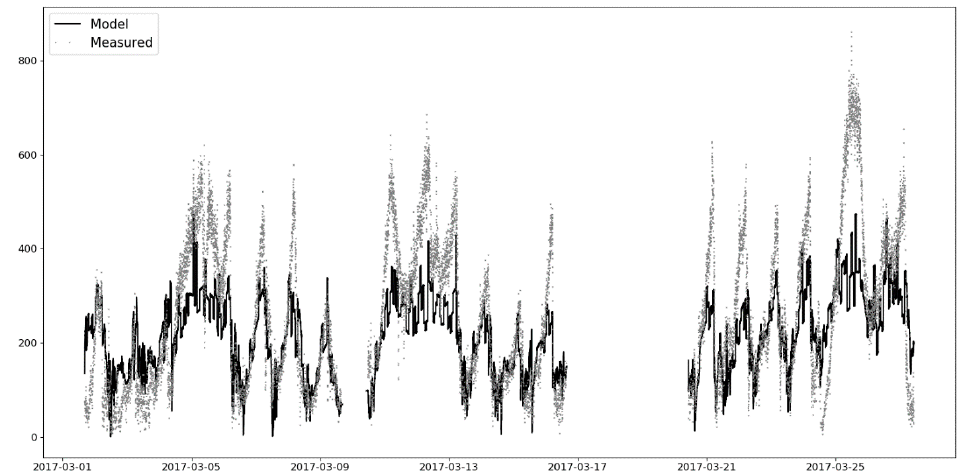
Figure 4. Comparison of a linear model based on radon and particle aggregates for School 1 (solid line) and a measurement of small ions (dotted line). Unit is [#/cm 3 ]. Training/test score 0.44/0.49.